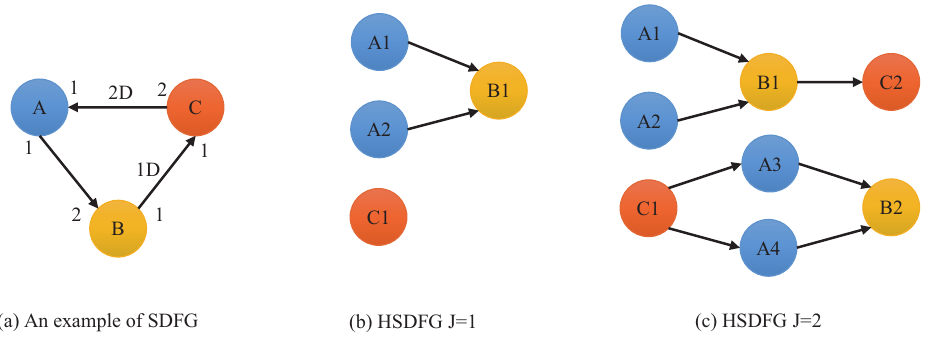
Figure 3. HSDFG is constructed by SDFG.